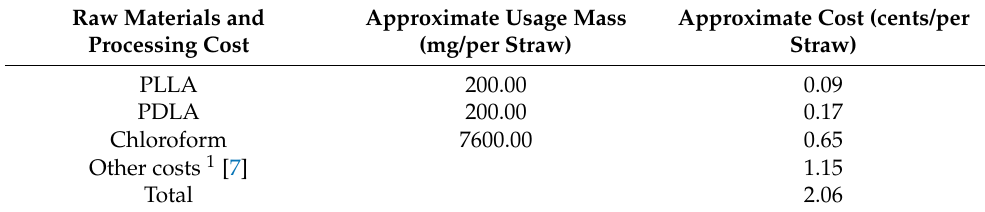
Table 4. Estimated cost of SC-PLA straws.